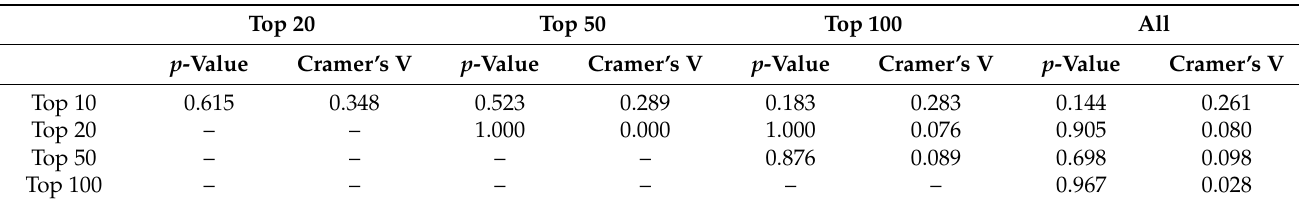
Figure 1. Frequencies of ACTN3 genotypes in professional badminton players. Table 2. Association between the ACTN3 genotypes and categories in professional European bad- minton players.